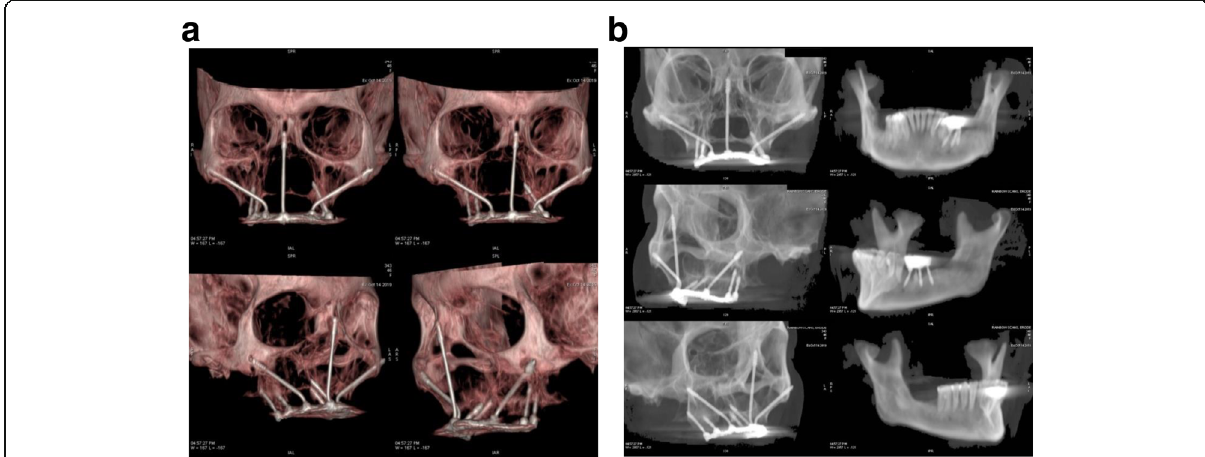
Fig. 6 a Post-operative CT coronal view: one zygomatic implant was used for the glabella region anchorage, engaging the floor of the frontal sinus, and in the mandible, three implants were placed in order to replace the left molar. b Post-operative CT sagittal view